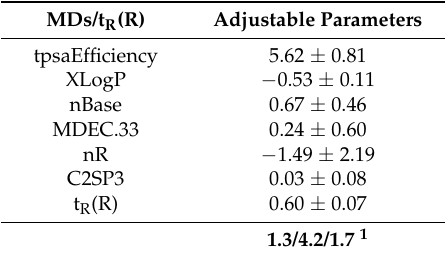
Table 2. QSRR model describing the retention of 94 metabolite standards for the Amide column based on Equation (1) and using their retention data on the Bare Silica column as a reference